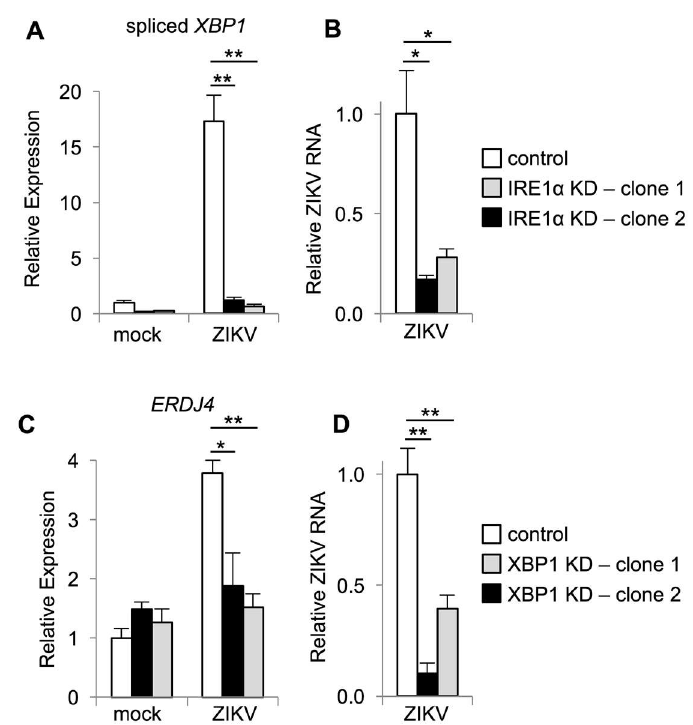
Figure 4. IRE1 α and XBP1 promote ZIKV replication. ( A – D ) IRE1 α or XBP1 knockdown (KD) cells generated using CRISPR-Cas9 were infected with ZIKV and RNA was harvested two days post-infection. The relative abundance of spliced XBP1 mRNA ( A ), ZIKV RNA ( B + D ), and ERDJ4 mRNA ( C ) were determined by quantitative RT-PCR. Data are means ± SD of three replicates and are representative of at least two independent experiments. * p < 0.05, ** p < 0.01, by unpaired t test. Viruses 2019 , 11 , x FOR PEER REVIEW